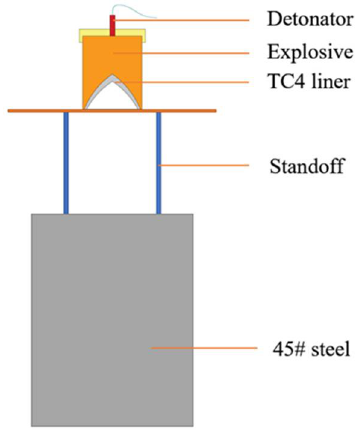
Figure 4. Schematic diagram of jet penetration into steel target.